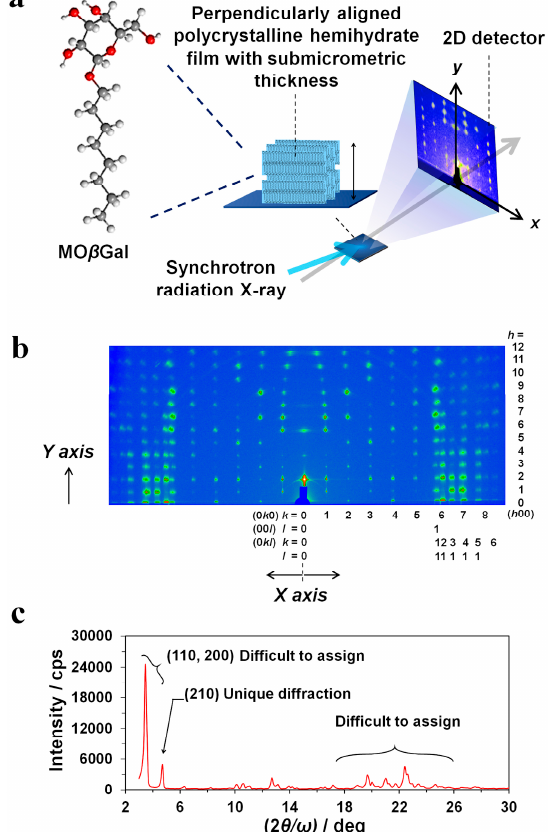
Figure 1. ( a ) Schematic of two-dimensional grazing incidence X-ray diffraction (GIXD) analysis for approximately 200-nm-thick octyl β - D -galactoside (MO β Gal) hemihydrate perpendicularly aligned polycrystalline films with synchrotron radiation. ( b ) GIXD image with the assignment of ( hkl ) indexes obtained for the sample shown in (a) with an incident angle of 0.17° and synchrotron radiation for 3 s at BLXU03, SPring8. ( c ) Powder X-ray diffraction (PXRD) image of the MO β Gal hemihydrate powder sample obtained using a conventional X-ray source (SmartLab) employing a one-dimensional detector.